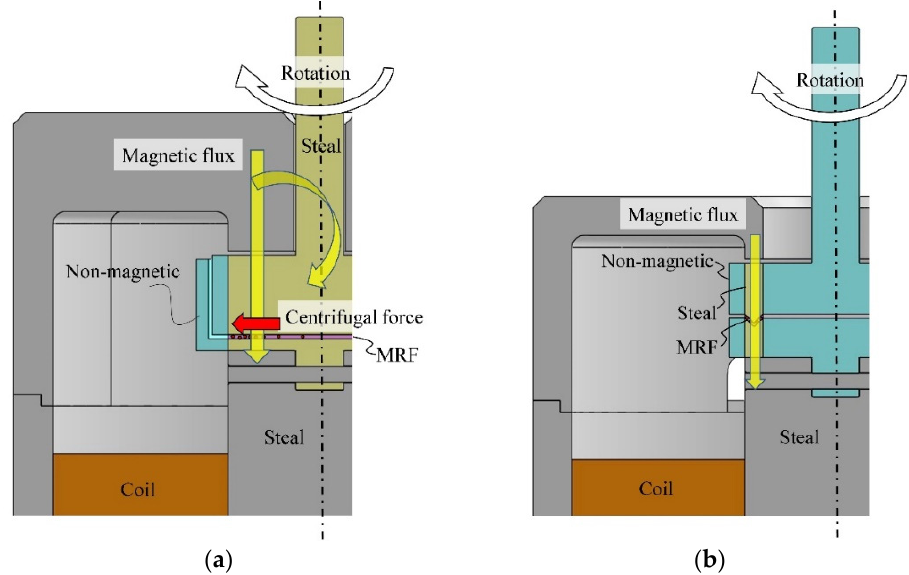
Figure 16. Difference between the parallel plate setting and V-shaped plate setting. ( a ) Parallel plate, ( b ) V-shaped plate.